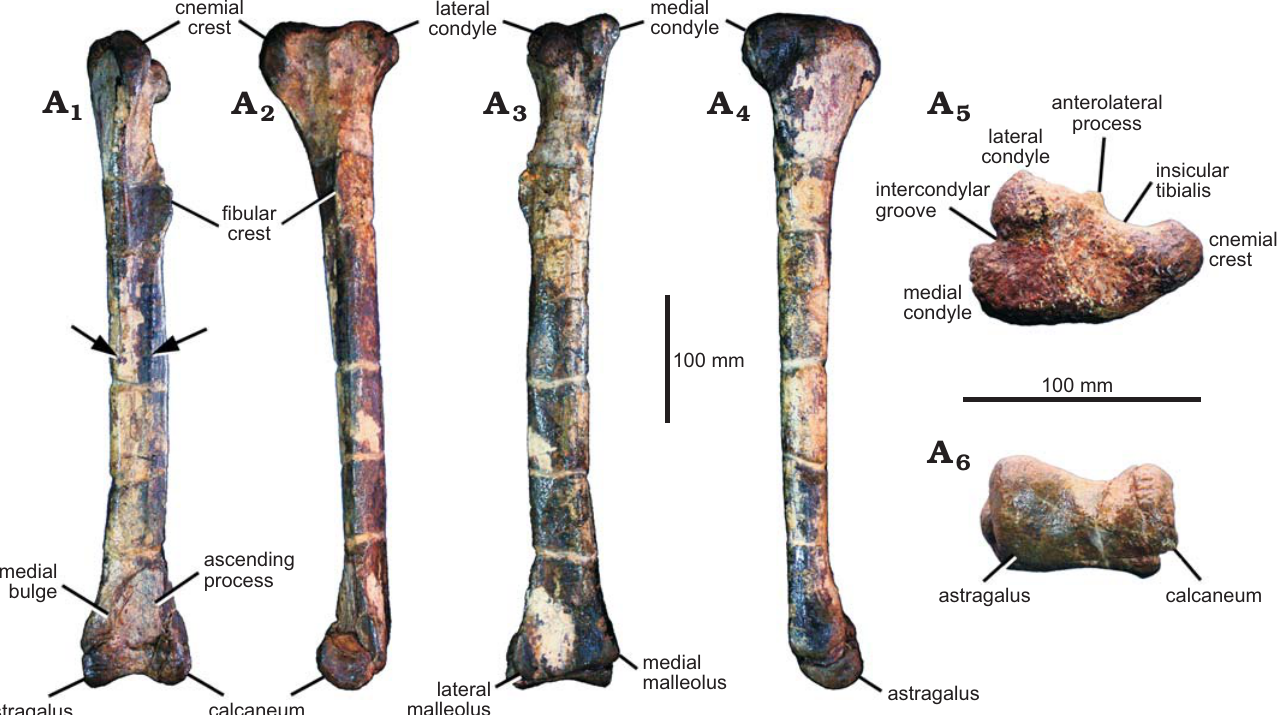
Fig. 16. Coelurosaurian theropod Vayuraptor nongbualamphuensis gen. et sp. nov. from the Early Cretaceous Sao Khua Formation of Phu Wat, Nong Bua Lamphu Province, Thailand. SM-NB A1-2, left tibia with associated astragalocalcaneum in anterior (A 1 ), lateral (A 2 ), posterior (A 3 ), medial (A 4 ), proximal (A 5 ), and distal (A 6 ) view. Arrow indicates vertical ridge on the tibia.